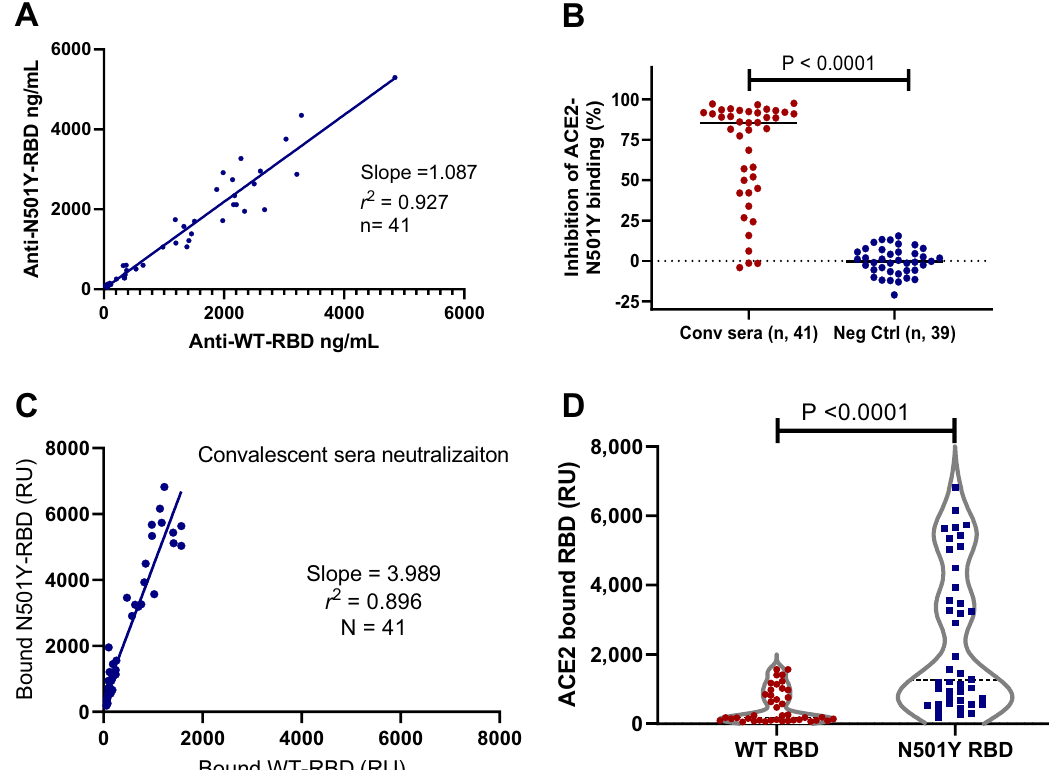
Figure 3. Comparison of antibody levels and neutralization activities against both the wildtype RBD and N501Y RBD proteins with convalescent sera. ( A ) Linearity of the anti-WT-RDB and anti-N501Y-RBD detected in the convalescent sera with a slope of 1.087 ( r 2 = 0.927). ( B ) Neutralization data from COVID-19 convalescent sera and negative controls. The convalescent sera had specific neutralizing activity against N501Y- RBD ( P < 0.0001). ( C ) Linear regression analysis of the ACE2 bound the WT and N501Y RBD detected using the COVID-19 convalescent sera with a slope of 3.99 ( r 2 = 0.896, N = 41). ( D ) N501Y RBD have much higher absolute ACE2 binding than the WT RBD in the presence of neutralizing convalescent sera ( P < 0.0001, N =